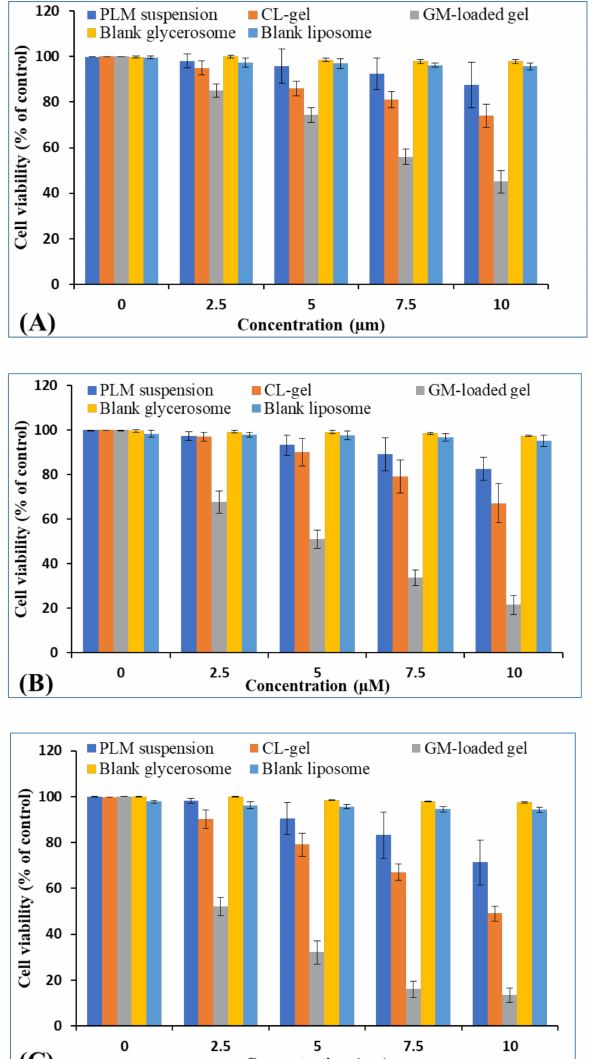
Figure 7. The cell viability of PLM suspension, CL and GM-loaded gel, blank GM and blank liposome